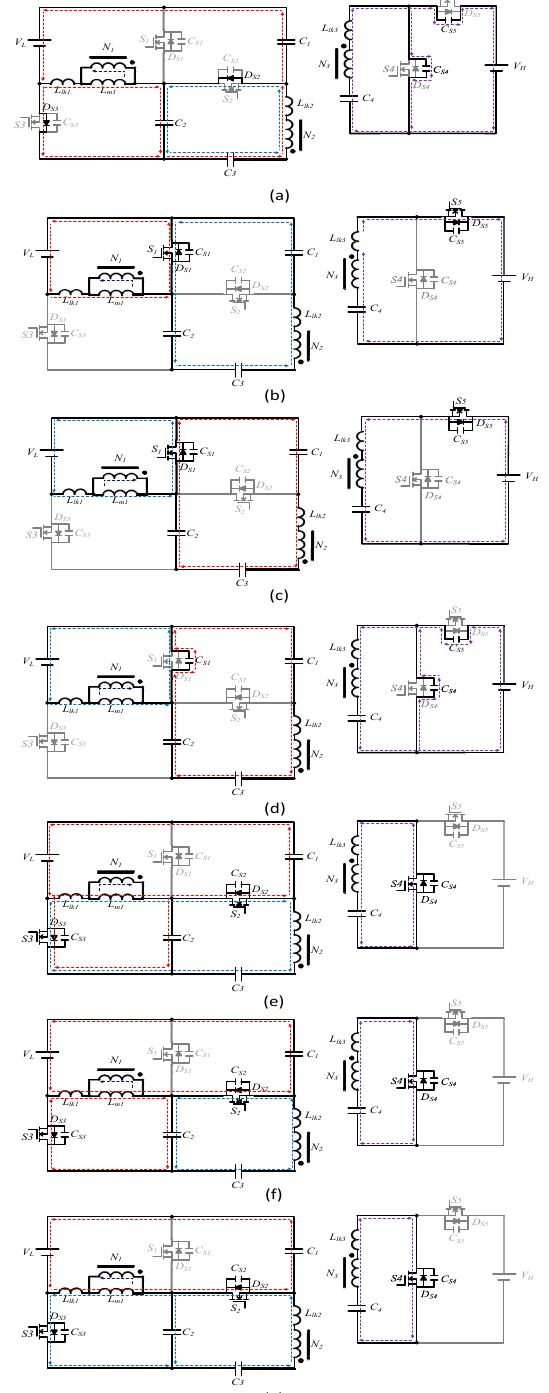
Figure 6. Equivalent circuits in the step-down mode: ( a ) Mode 1, ( b ) Mode 2, ( c ) Mode 3, ( d ) Mode 4, ( e ) Mode 5, ( f ) Mode 6, and ( g ) Mode 7. ( e ) Mode 5, ( f ) Mode 6, and ( g ) Mode